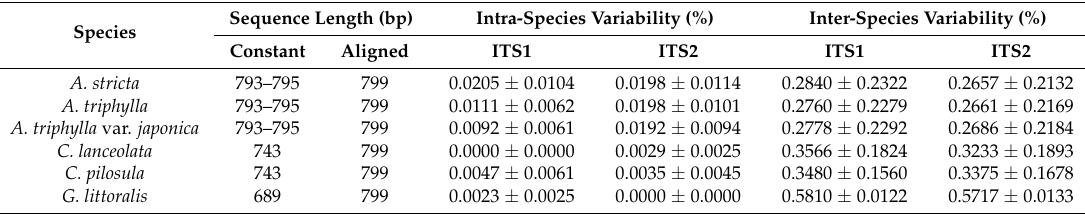
Table 2. Summary of the characteristics of nrDNA-ITS barcode sequences.